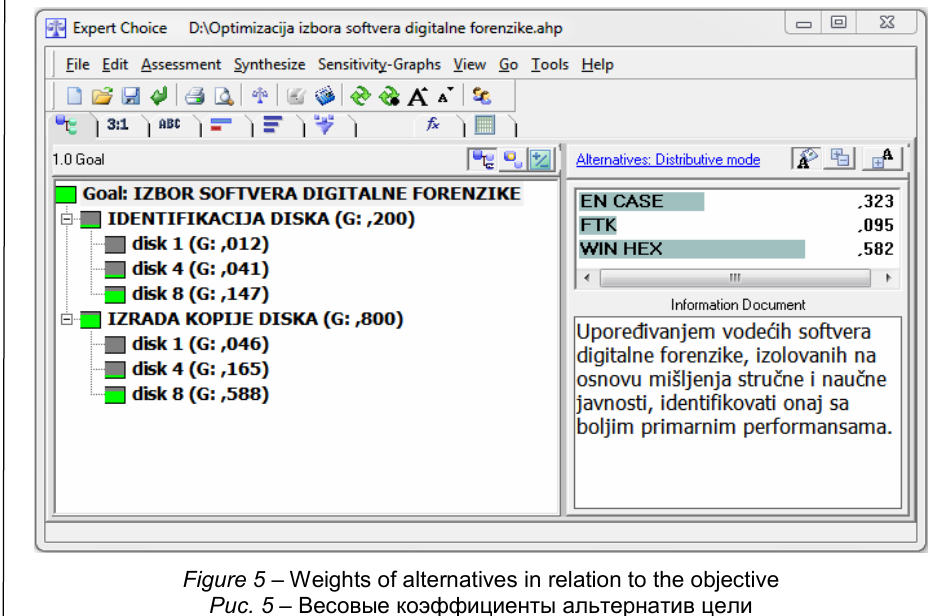
Figure 5 – Weights of alternatives in relation to the objective Рис . 5 – Весовые коэффициенты альтернатив